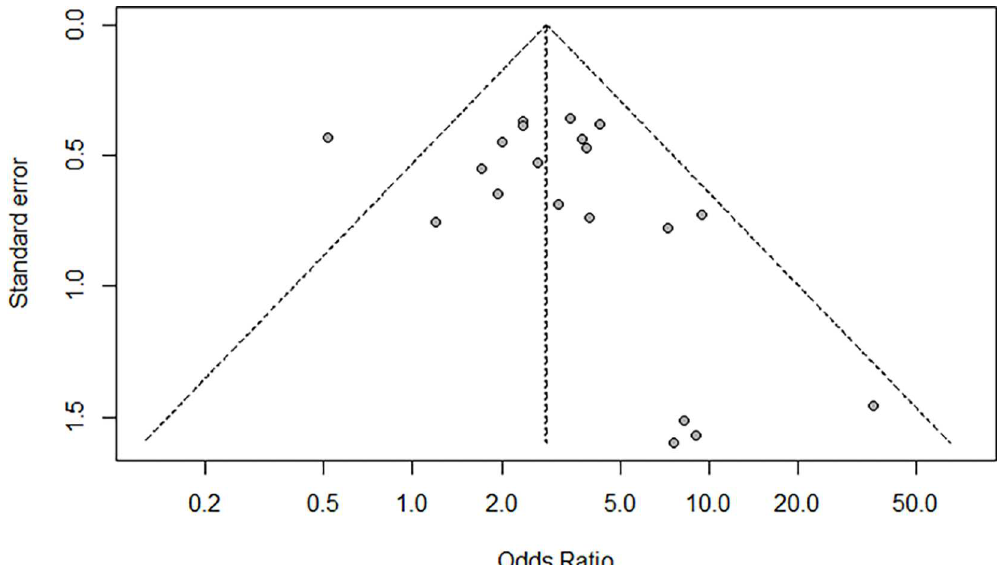
Fig 4. Funnel plot for assessment of publication bias in the